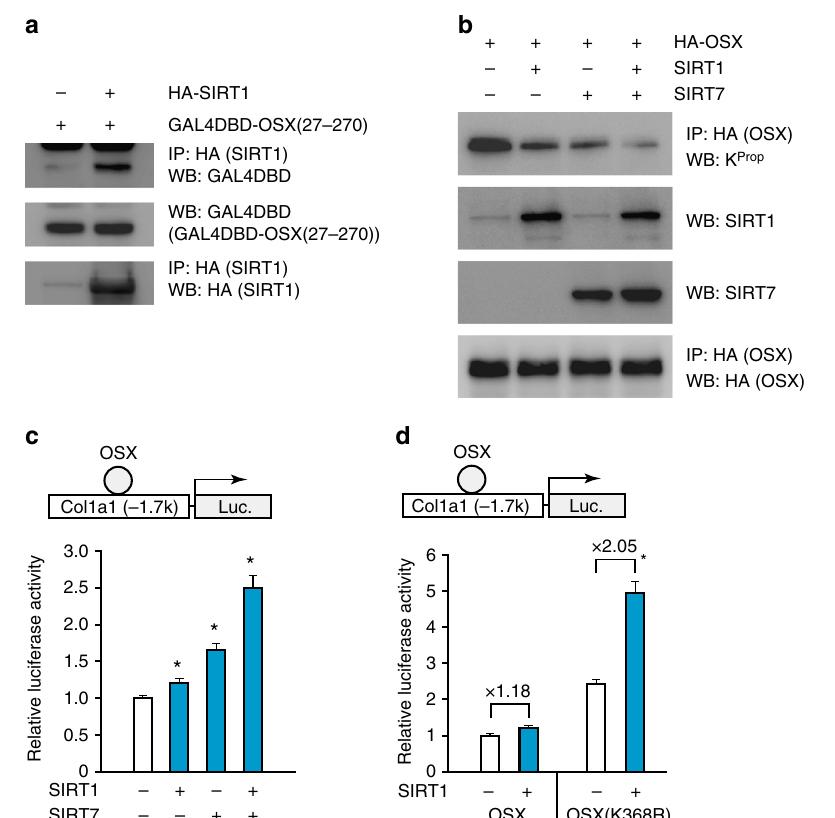
Fig. 8 SIRT7 and SIRT1 regulate OSX transactivation activity through lysine deacylation. a Co-immunoprecipitation assay to assess the interaction between HA-SIRT1 and GAL4DBD-OSX (27 – 270) in HEK293T cells. b Effect of SIRT7 and SIRT1 overexpression on propionylation of OSX. Sirt7 KO MEF were transfected with the 3× HA-OSX expression plasmid, as well as the SIRT7 or SIRT1 expression plasmid, followed by treatment with 50 mM Na-Prop for 16 h. Then propionylation of OSX was assessed by immunoprecipitation and WB. c Effect of SIRT7 and SIRT1 overexpression on transactivation activity of OSX. Sirt7 KO MEF were transfected with the 3× HA-OSX expression plasmid, as well as the SIRT7 or SIRT1 expression plasmid, followed by treatment with 10 mM Na-Prop for 24 h. Then the cells were transfected with the Col1a1 enhancer/promoter-driven luciferase reporter plasmid, and the reporter assay was performed after 24 h ( n = 6 each). d Effect of SIRT1 on transactivation activity of the OSX (K368R) mutant. Sirt7 KO MEF were transfected with the 3× HA- OSX or 3× HA-OSX (K368R) expression plasmid, as well as the SIRT1 expression plasmid, followed by treatment with 30 mM Na-Prop for 24 h. Then the cells were transfected with the Col1a1 enhancer/promoter-driven luciferase reporter plasmid, and the reporter assay was performed after 24 h ( n = 6 each). WB, western blotting; IP, immunoprecipitation. Data are shown as the mean ± SEM. Statistical signi fi cance was determined by Student ’ s t -test. * p < 0.05 vs. without SIRT1 and SIRT7 ( c